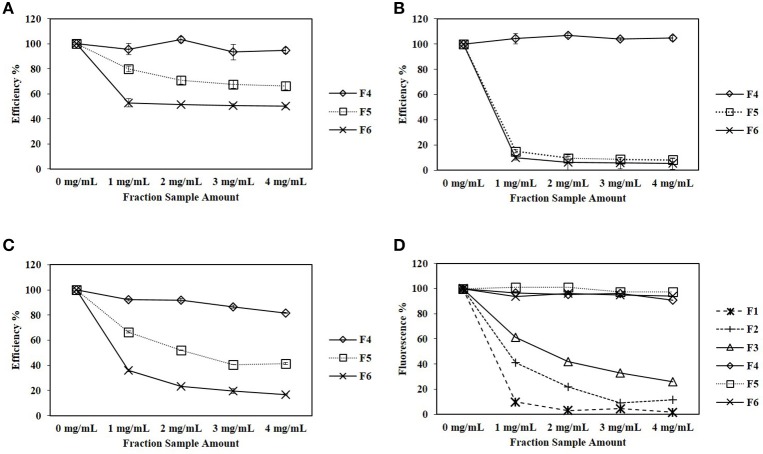
(A–C) Effects of CPC fractionated pinewood HW pre-hydrolyzates on E1, CBHI and CBHII enzymatic efficiency during the MUC assay. (D) Effects of CPC fractions directly on MU fluorescence without enzyme. Standard error bars in (A–C) were used to represent the deviation.